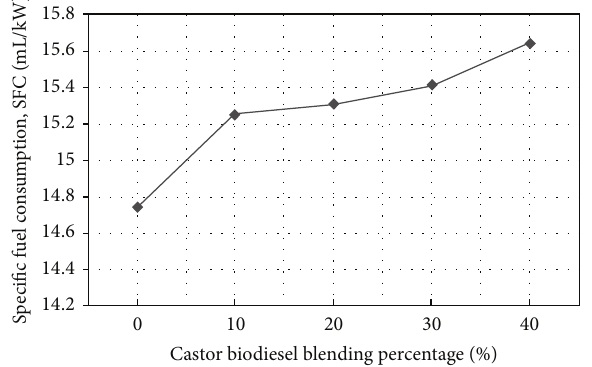
Figure6:Specificfuelconsumptionversuscastorbiodieselblending percentage.